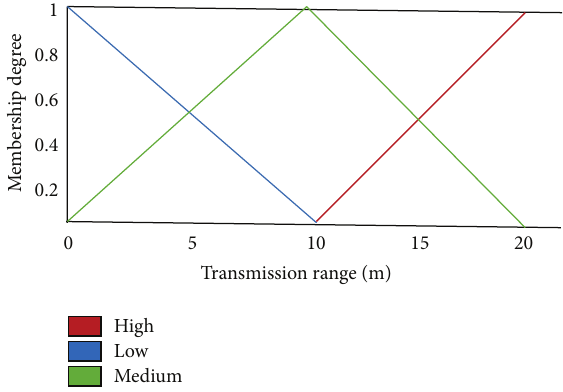
Figure 4: Fuzzy set for fuzzy input variable transmission range.